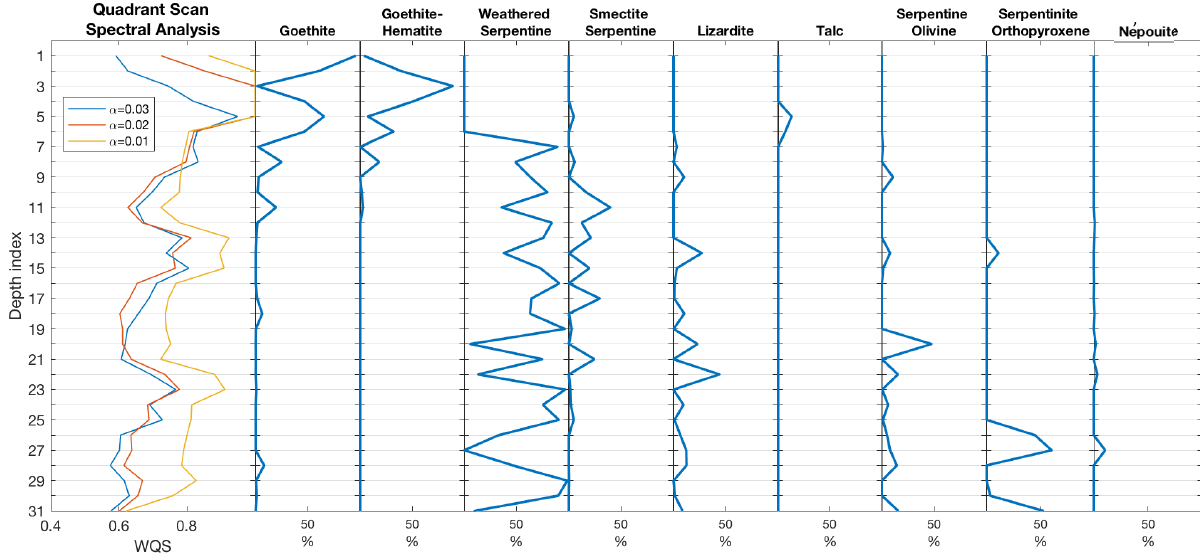
Figure 11. BOULINDA drill-hole: The WQS analysis in comparison with the abundance percentage of different minerals obtained with Corescan. The left panel is the WQS results from the spectral data using three different values of 𝛼 , peaks indicate lithological, alteration and weathering boundaries. The rest of the panels show the abundance percentage of different minerals along the drill-hole.